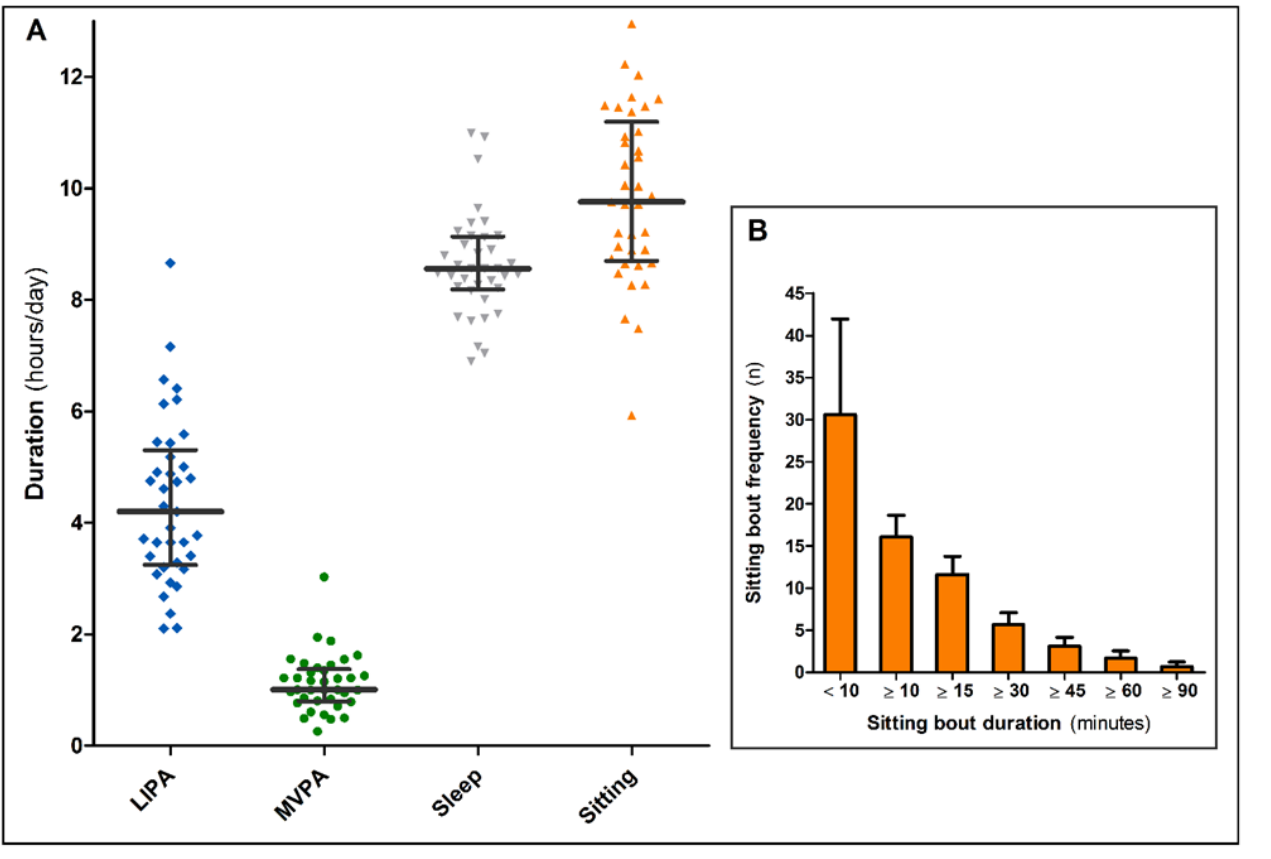
Figure 2. ( A ) objectively measured light-intensity physical activity (LIPA), moderate-to-vigorous intensity physical activity (MVPA), sleep duration and sedentary time in patients with COVID-19 at 125 [116, 132] days post-hospitalisation (box plots with median and interquartile range). ( B ) sitting bout frequency (mean + standard deviation) with a single bout duration ranging from <10 min up to ≥ 90